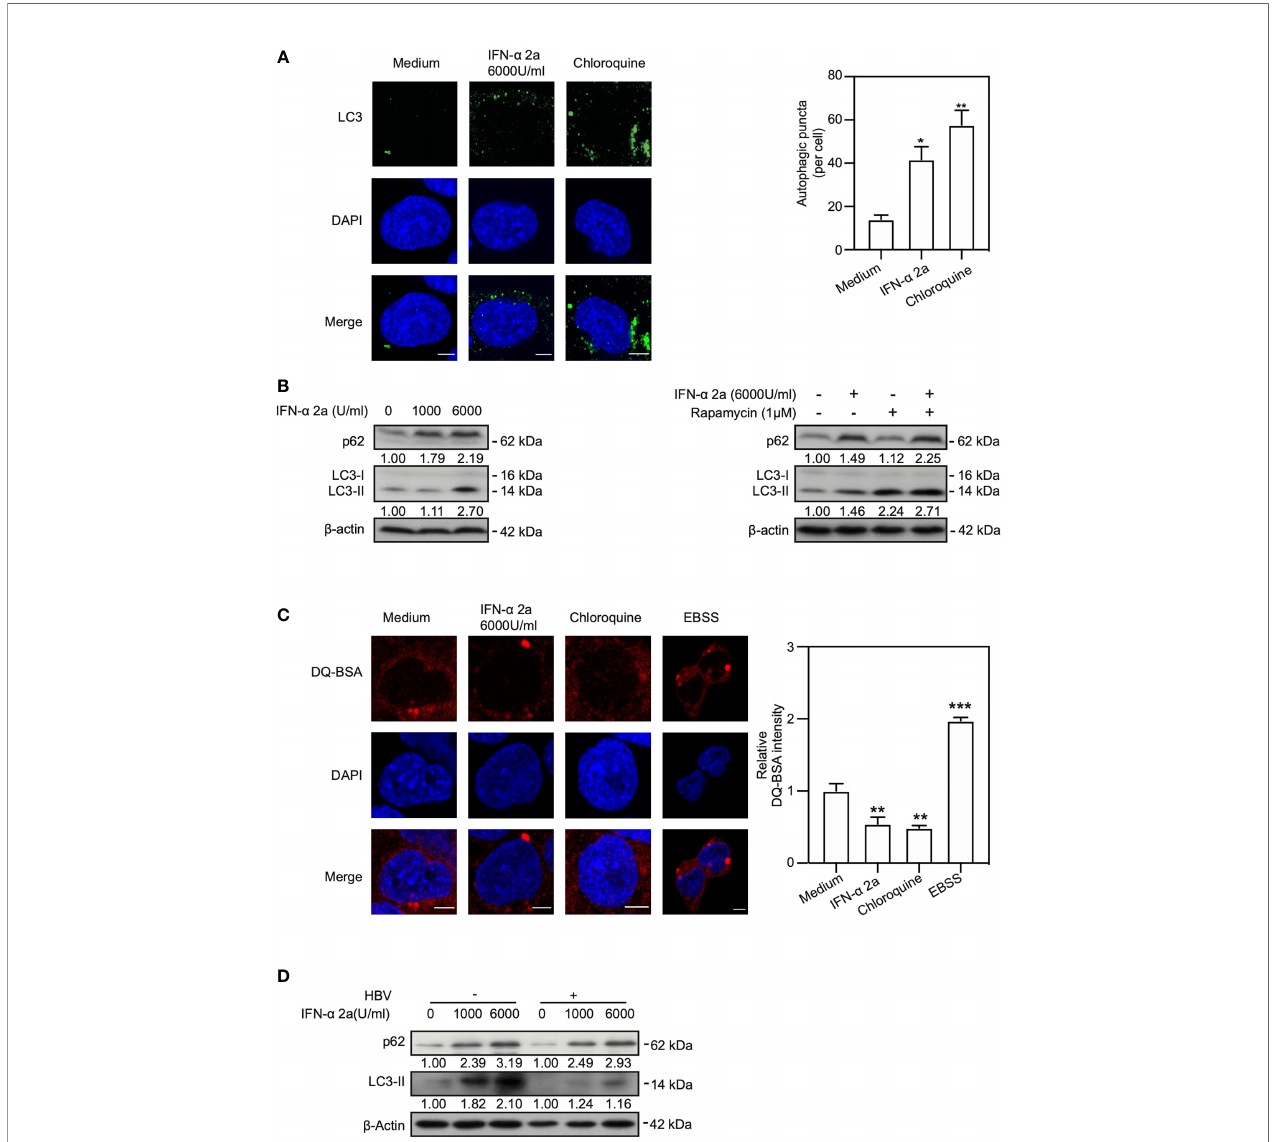
FIGURE 2 | IFN a -2a induces autophagy through inhibiting Akt/mTOR pathway and blocks autophagic degradation. (A) HepG2.2.15 cells were treated with 6000 U/ ml IFN a -2a. After 48 hr, cells were fi xed, incubated with rabbit anti-LC3 antibodies, followed by staining with Alexa Fluor 488-conjugated anti-rabbit secondary antibody IgG. Finally, the distribution of LC3 was imaged by confocal microscopy. Cells treated with 10 nM chloroquine (CQ) were used as a positive control. LC3 puncta in cells were quanti fi ed as described previously (Lin et al., 2020). Scale bar: 5 m m. (B) HepG2.2.15 cells were treated with the indicated concentrations of IFN a -2a and harvested after 48 hr. HepG2.2.15 cells were cultured in the medium either with 6000 U/ml IFN a -2a or rapamycin (1 m M) for 48 hr. p62 and LC3 were analyzed by western blotting using beta ‐ actin as a loading control. The relative levels were determined by quantifying the gray scales of bands, using beta ‐ actin as a loading control. (C) HepG2.2.15 cells were treated with 6000 U/ml IFN a -2a for 48 hr, followed by incubation with 10 m g/mL DQ-BSA for 30 minutes. The fl uorescent signal of DQ-BSA was detected by confocal microscopy. Cells cultured with EBSS for 2 hours were used as a positive control and CQ treatment was as a